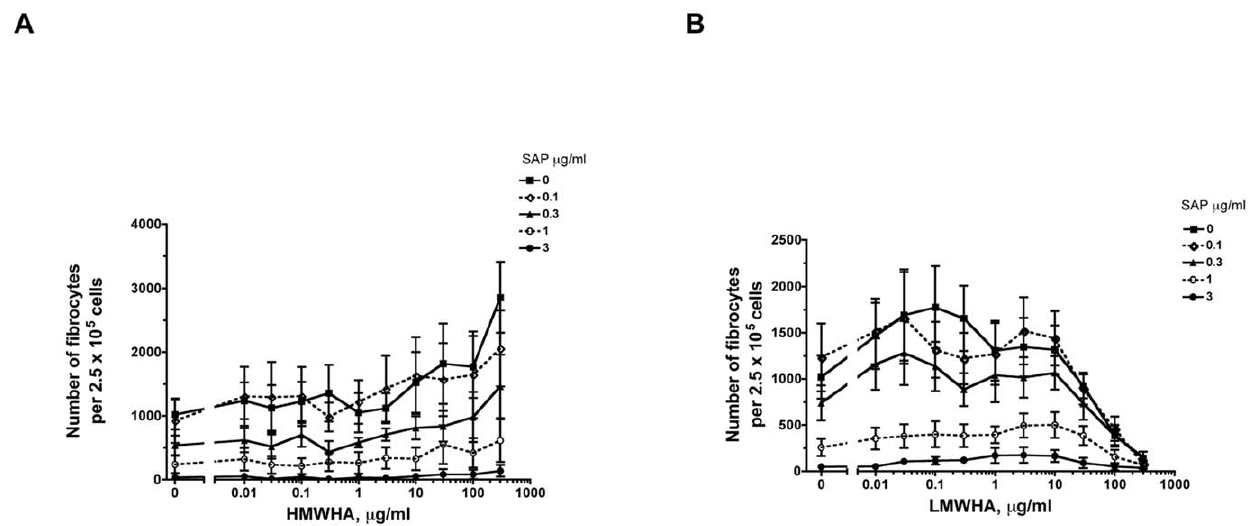
Figure 10. SAP inhibits HMWHA-induced fibrocyte differentiation and potentiates LMWHA-induced fibrocyte inhibition. ( A ) Human PBMC were cultured in different concentrations of HMWHA with 0, 0.1, 0.3, 1, and 3 m g/ml of SAP. After 5 days, the cells were air dried, fixed, stained, and the number of fibrocytes was counted. The results are mean 6 SEM of fibrocytes per 2.5 6 10 5 PBMC (n=5 separate experiments, except n=11 separate experiments for HMWHA with no SAP). With no SAP, the difference between no treatment and 300 m g/ml HMWHA is significant with p , 0.01 (t-test). With 300 m g/ml HMWHA, adding 1 or 3 m g/ml SAP significantly decreases the number of fibrocytes with p , 0.05 (ANOVA). Using the non-parametric Mann Whitney two-tailed t-test, with no SAP, the difference between no treatment and 300 m g/ml HMWHA is significant with p , 0.05. With 300 m g/ml HMWHA, adding 1 or 3 m g/ml SAP significantly decreases the number of fibrocytes with p , 0.05. ( B ) Human PBMC were cultured in different concentrations of LMWHA with 0, 0.1, 0.3, 1, and 3 m g/ml of SAP for 5 days. After 5 days, the cells were air dried, fixed, stained, and the number of fibrocytes was counted. The results are mean 6 SEM of fibrocytes per 2.5 6 10 5 PBMC (n=5 separate experiments, except n=11 separate experiments for LMWHA with no SAP). With no added SAP, the difference between no treatment and 100 m g/ml or 300 m g/ml LMWHA is significant with p , 0.001 (t-test). Using the non-parametric Mann Whitney two-tailed t-test, with no added SAP, the difference between no treatment and 100 m g/ml or 300 m g/ml LMWHA is significant with p , 0.05.